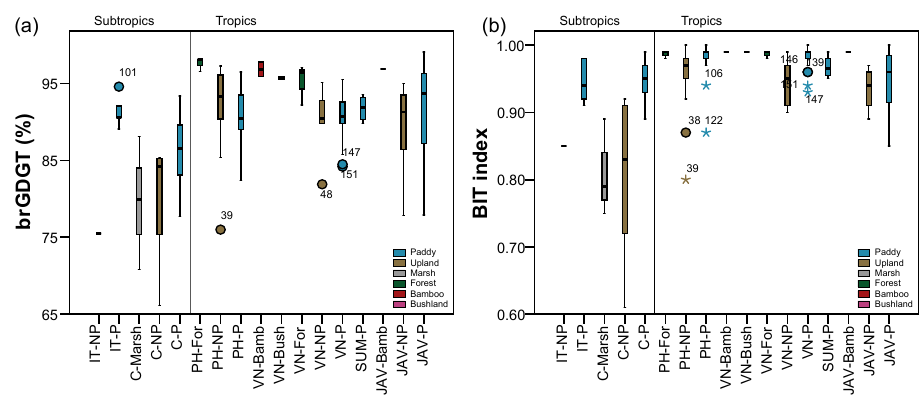
Figure 4. Box-plot diagrams of (a) the relative proportion of brGDGT in the total GDGT pool and (b) the BIT index in soil. Note different symbols (circle or asterisk) for outliers that are more than 1.5 (or 3) box lengths from one hinge of the box. Abbreviations and subdivisions as in Fig. 2.